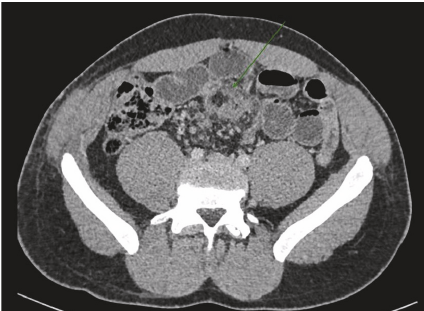
Figure 1: Contrast enhanced axial CT image at the time of injury demonstrated high attenuation haematoma within the small bowel mesentery (arrow).